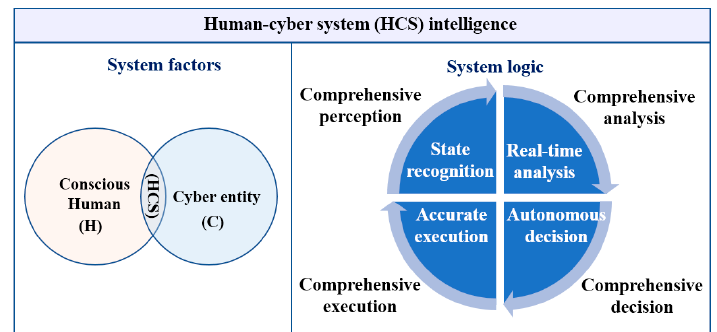
Figure 7. HCS intelligence (Type II).